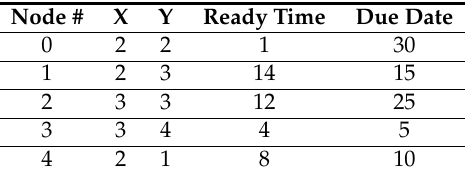
Table 5. The input data for the network G 2 .